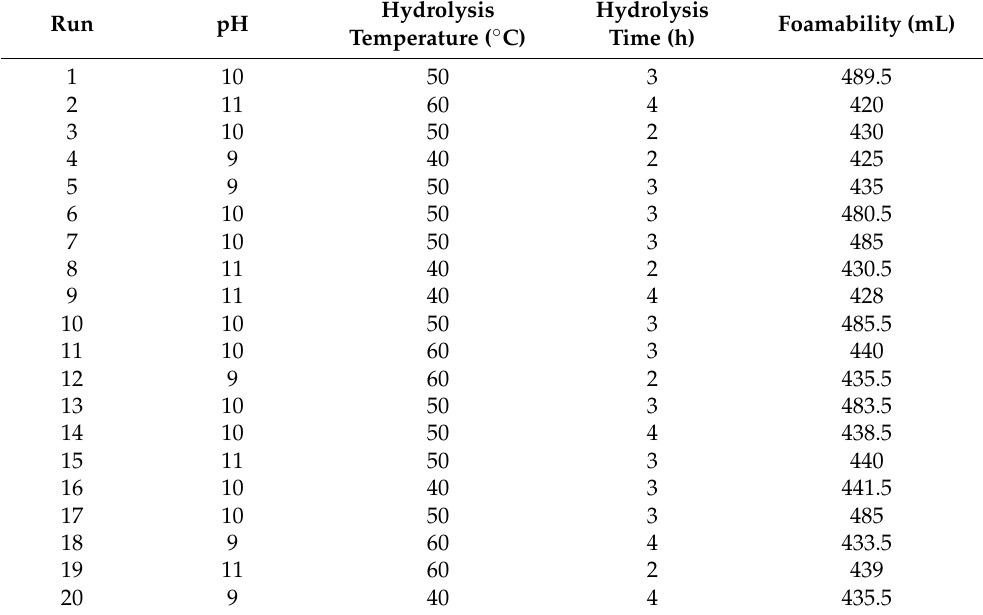
Table 4. BBD experimental